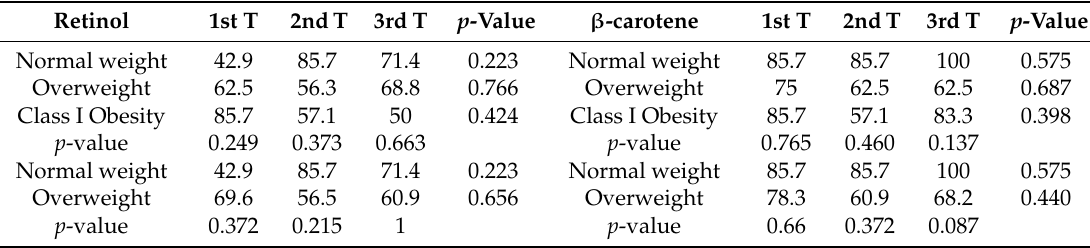
Table 2. Percentage of inadequacy of retinol and β -carotene in different classes of pre-pregnancy BMI, per trimesters of pregnancy.